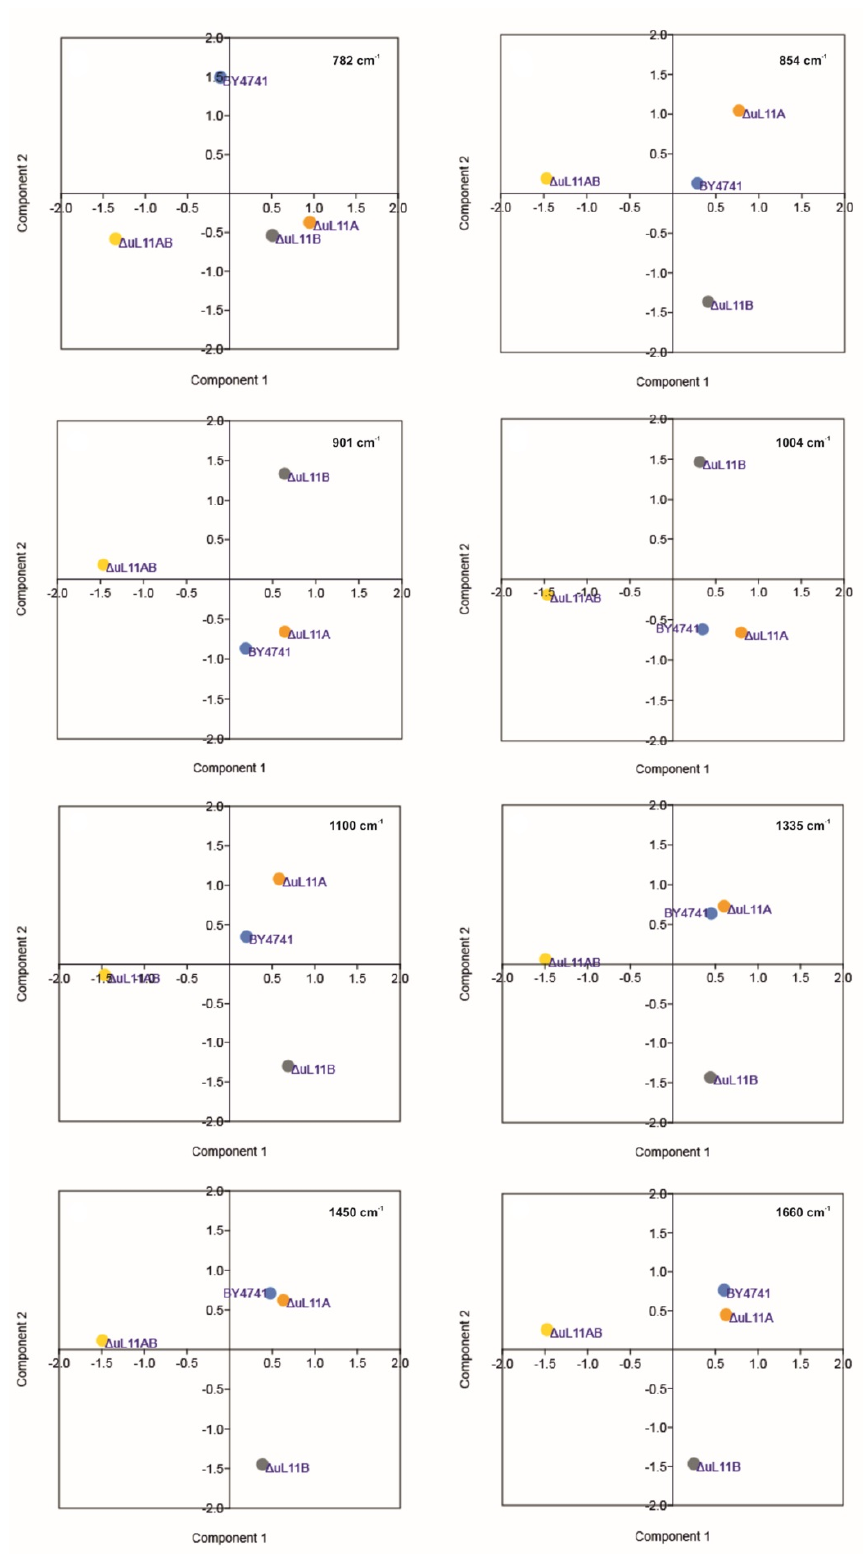
Figure11. Principalcomponentanalysis(PCA)ofyeastdatafromRamanspectroscopy. Two-dimensional (2D) score plot of yeast mutants presented through measurements of spectral functional groups showing di ff erences in the metabolic compositions. For PCA analysis, the intensity of Raman peaks was used at the appropriate wavelength for the functional group for eight independent replicates for each object. Insets on the top right represents the individual peak values taken for analysis, recorded by Raman spectroscopy